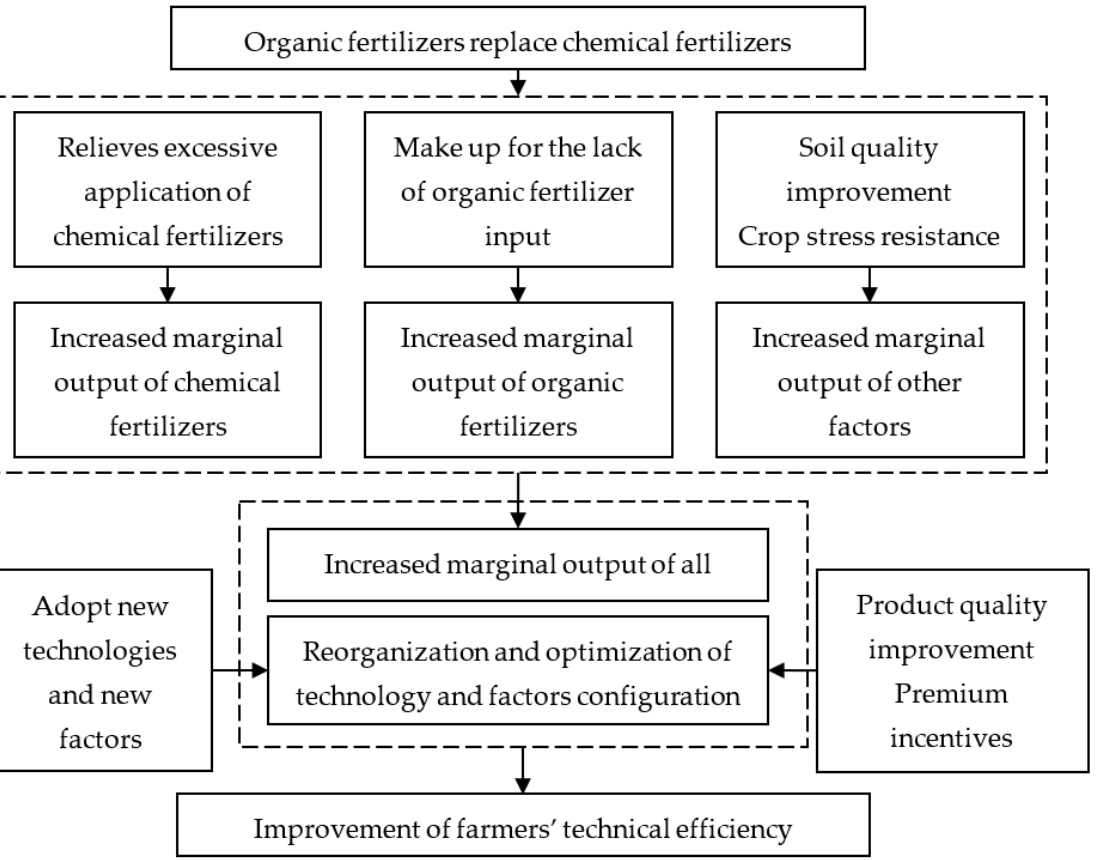
Figure 1. Influence mechanism of organic fertilizer substitution of chemical fertilizer on the farmers’ technical efficiency.